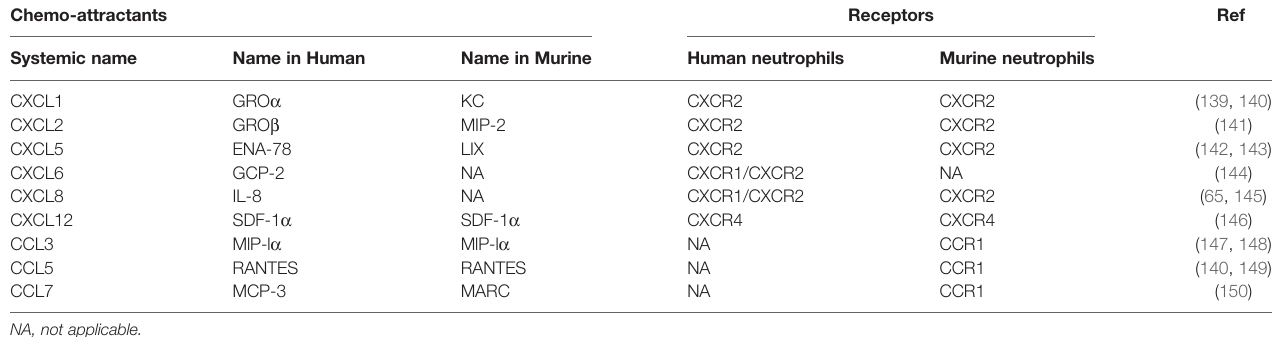
TABLE 2 | Main murine and human chemo-attractants and their receptors expressed in neutrophils during pulmonary infection and in fl ammation.